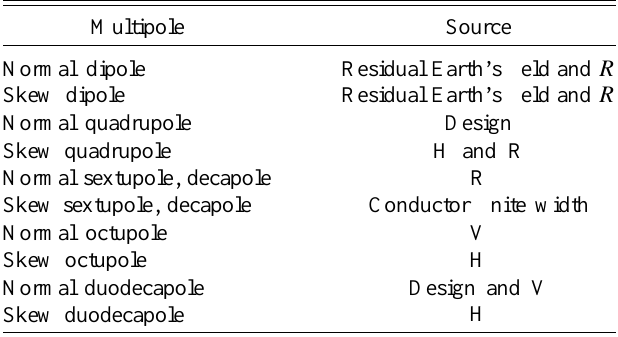
TABLE IV. Sources of PC quadrupole multipole spectrum (see Tables II and III). Multipole Source Normal